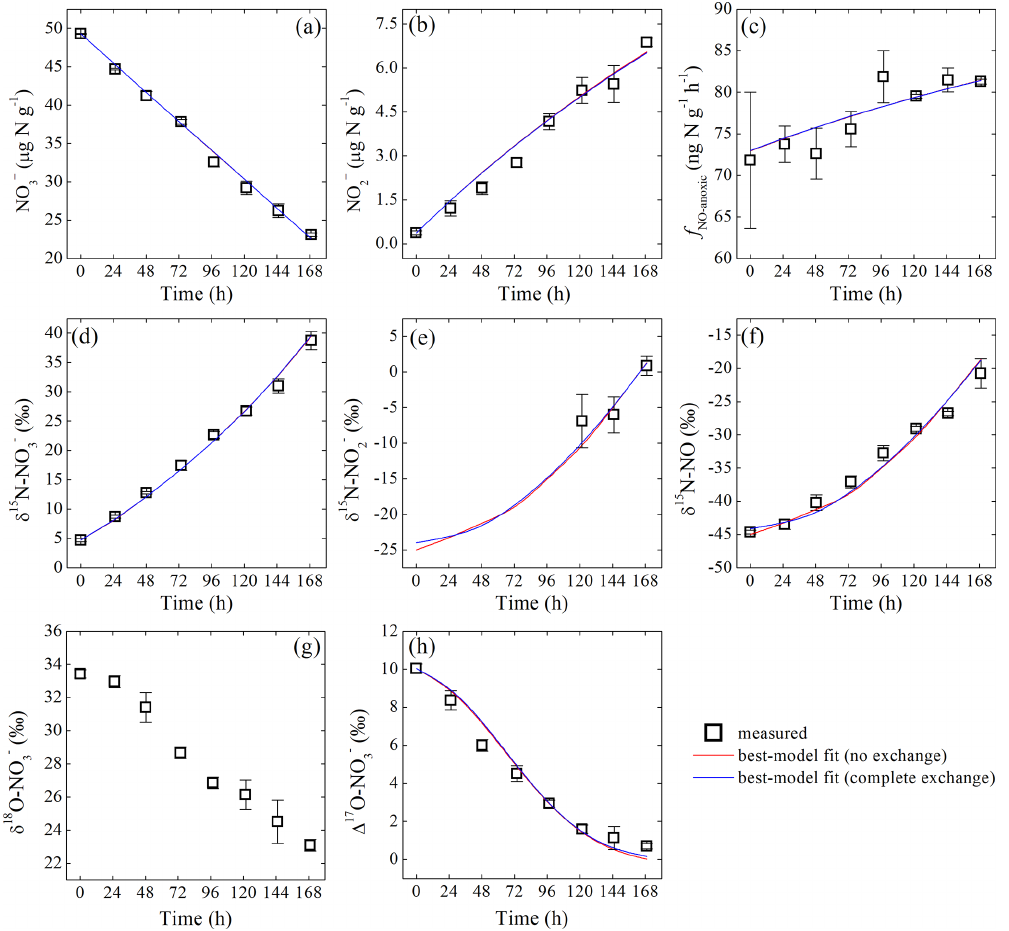
Figure 2. Measured and modeled concentrations of NO − and NO (f) ; and δ 18 O (g) and (cid:49) 17 O (h) of NO −